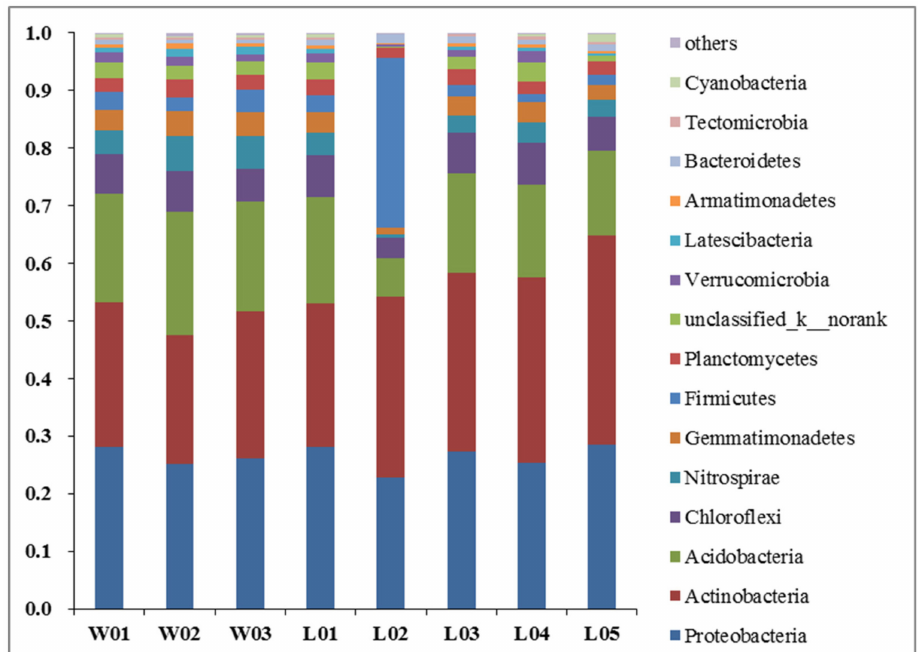
Figure 7. Distribution of relative abundance of di ff erent bacterial community structures at phylum levels of di ff erent treatments in soil (W01–W03 represents soil microorganisms of each sample vertically, and L01–L05 represents soil microorganisms of each sample horizontally).